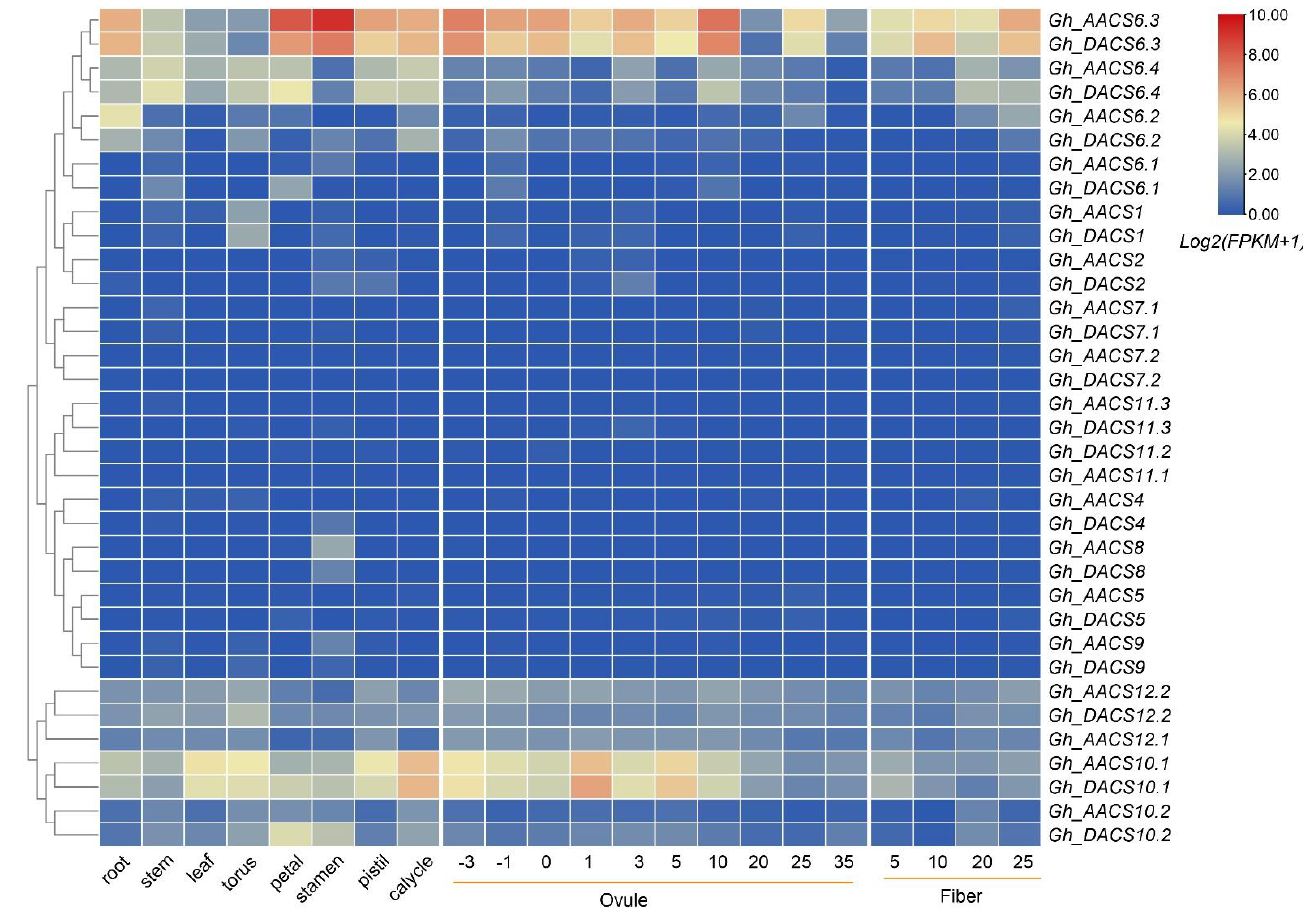
Figure 7. Tissue-specific expression patterns of the GhACS genes. The heatmap shows the expression levels of GhACS genes in 22 tissues, including root, stem, leaf, torus, petal, stamen, pistil, calycle, ovules, and fibers, at different development stages.